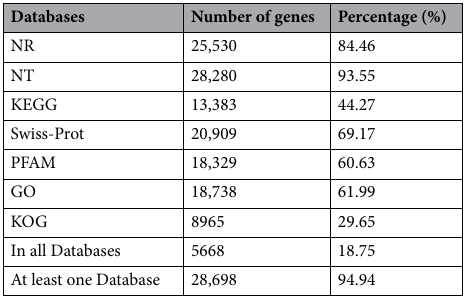
Table 2. Statistics of BLASTX database searches for gene sequences.